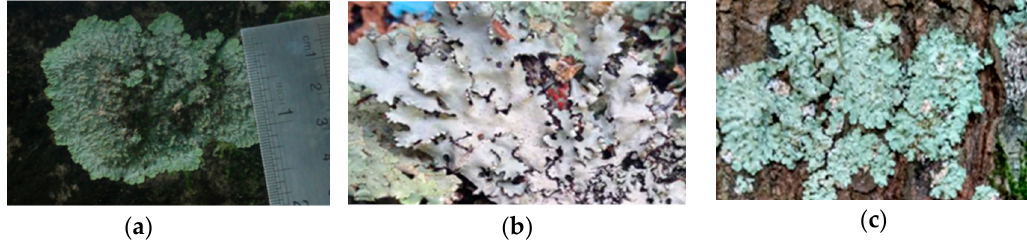
Figure 2. Folious lichen isolated from East Java-Java Island Indonesia: ( a ) Physcia millegrana Degel, ( b ) Parmelia dilatata Vain and ( c ) Parmelia aurulenta Tuck.